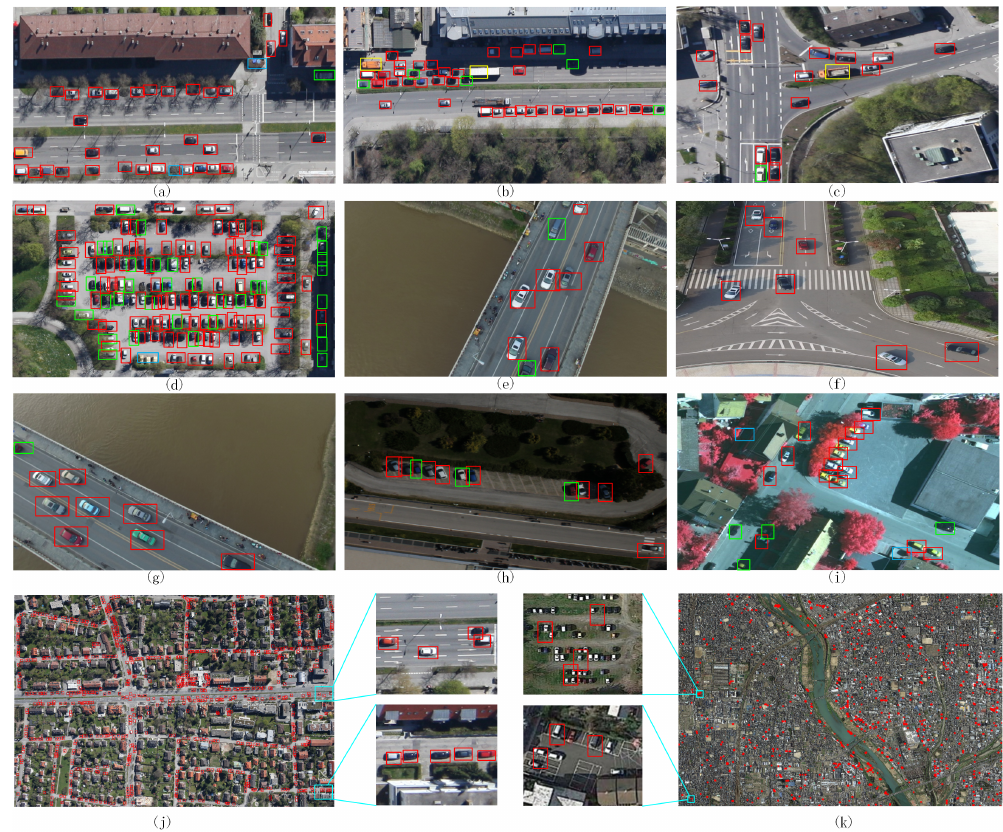
Figure 12. Detection results from test images. Red boxes denote correct localization of car, yellow boxes denote correct localization of truck, green boxes and blue boxes denote missing detection and incorrect detection, respectively. ( a – d ) are results for the Munich test aerial image blocks; ( e – h ) are results on unmanned aerial vehicle (UAV) images; ( i ) is results for pansharpened color infrared (CIR) image; ( j ) is results for the original large-scale Munich test image; ( k ) is results for a large satellite image of